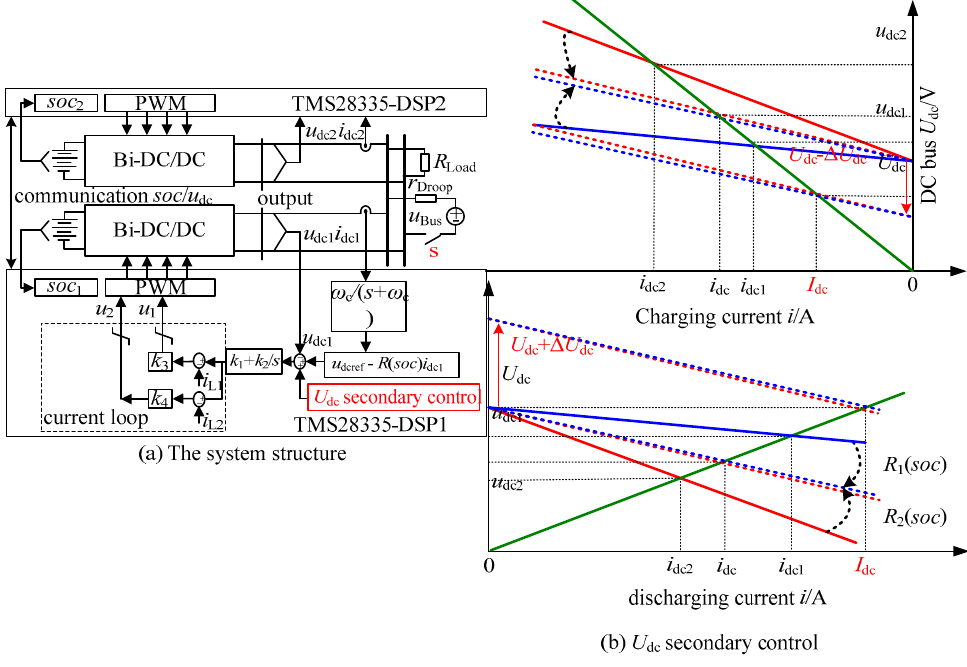
Figure 9. The diagram of distributed energy storage systems.